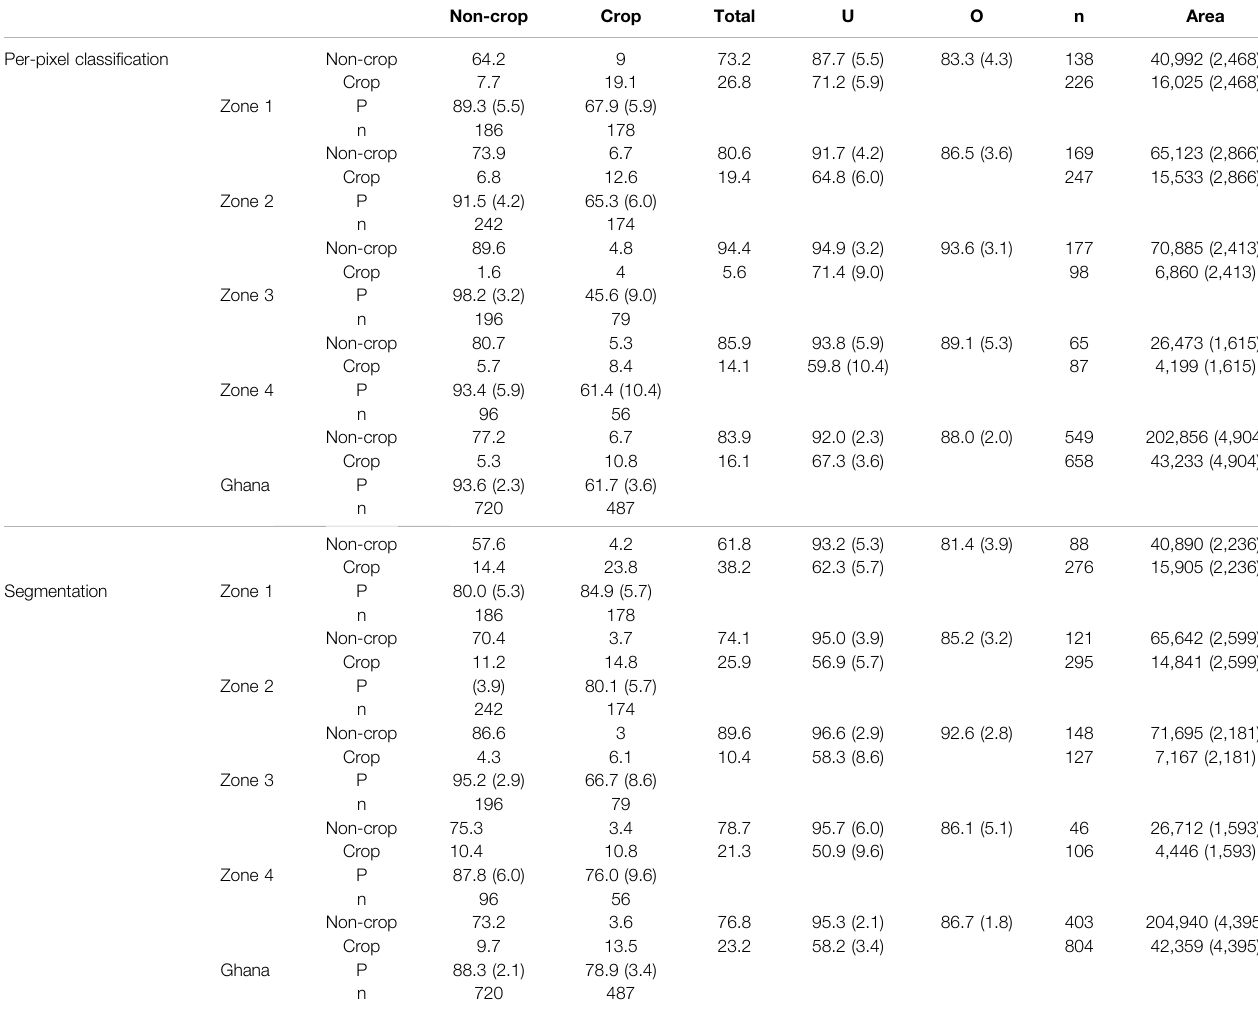
TABLE 2 | Map accuracies and adjusted area estimates for the 3 m pixel-wise classi fi cations (based on Random Forests predictions; top 5 rows) and the segmented map (bottom5rows).Resultsareprovidedfor4zones(Zone1 (cid:1) AOIs1 – 3;Zone2 (cid:1) AOIs4 – 9;Zone3 (cid:1) AOIs10,11,13,14,16;Zone4 (cid:1) AOIs12,15)plustheentirecountry. The error matrix (with reference values in columns) provides the areal percentage for each cell, and the Producer ’ s (P), User ’ s (U), and overall (O) map accuracies and their margins of error (in parenthesis) are provided, as well as the sample-adjusted area estimates (in km 2 ) and margins of